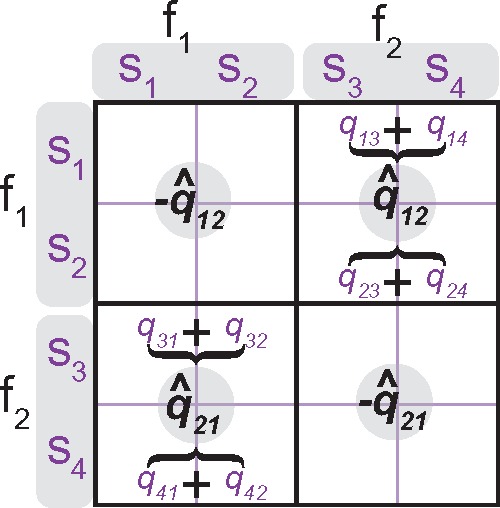
Lumpable Markov model. Symmetries in the rate matrix that are necessary for strong lumpability (row-wise sum rule); the original four-state {\documentclass[12pt]{minimal}
\usepackage{amsmath}
\usepackage{wasysym}
\usepackage{amsfonts}
\usepackage{amssymb}
\usepackage{amsbsy}
\usepackage{upgreek}
\usepackage{mathrsfs}
\setlength{\oddsidemargin}{-69pt}
\begin{document}
}{}$s_{1}, s_{2}, s_{3}, s_{4}$\end{document}} matrix with rates \documentclass[12pt]{minimal}
\usepackage{amsmath}
\usepackage{wasysym}
\usepackage{amsfonts}
\usepackage{amssymb}
\usepackage{amsbsy}
\usepackage{upgreek}
\usepackage{mathrsfs}
\setlength{\oddsidemargin}{-69pt}
\begin{document}
}{}$q_{ij}$\end{document} is aggregated into the two-state \documentclass[12pt]{minimal}
\usepackage{amsmath}
\usepackage{wasysym}
\usepackage{amsfonts}
\usepackage{amssymb}
\usepackage{amsbsy}
\usepackage{upgreek}
\usepackage{mathrsfs}
\setlength{\oddsidemargin}{-69pt}
\begin{document}
}{}$\{f_{1} = \{s_{1}, s_{2}\}, f_{2} = \{s_{3}, s_{4}\}\}$\end{document} matrix with rates \documentclass[12pt]{minimal}
\usepackage{amsmath}
\usepackage{wasysym}
\usepackage{amsfonts}
\usepackage{amssymb}
\usepackage{amsbsy}
\usepackage{upgreek}
\usepackage{mathrsfs}
\setlength{\oddsidemargin}{-69pt}
\begin{document}
}{}$\hat{q}_{ij}$\end{document}; the aggregation is lumpable iff \documentclass[12pt]{minimal}
\usepackage{amsmath}
\usepackage{wasysym}
\usepackage{amsfonts}
\usepackage{amssymb}
\usepackage{amsbsy}
\usepackage{upgreek}
\usepackage{mathrsfs}
\setlength{\oddsidemargin}{-69pt}
\begin{document}
}{}$\hat{q}_{12}=q_{13}+q_{14}=q_{23}+q_{24}$\end{document} and \documentclass[12pt]{minimal}
\usepackage{amsmath}
\usepackage{wasysym}
\usepackage{amsfonts}
\usepackage{amssymb}
\usepackage{amsbsy}
\usepackage{upgreek}
\usepackage{mathrsfs}
\setlength{\oddsidemargin}{-69pt}
\begin{document}
}{}$\hat{q}_{21}=q_{31}+q_{32}=q_{41}+q_{42}$\end{document}.